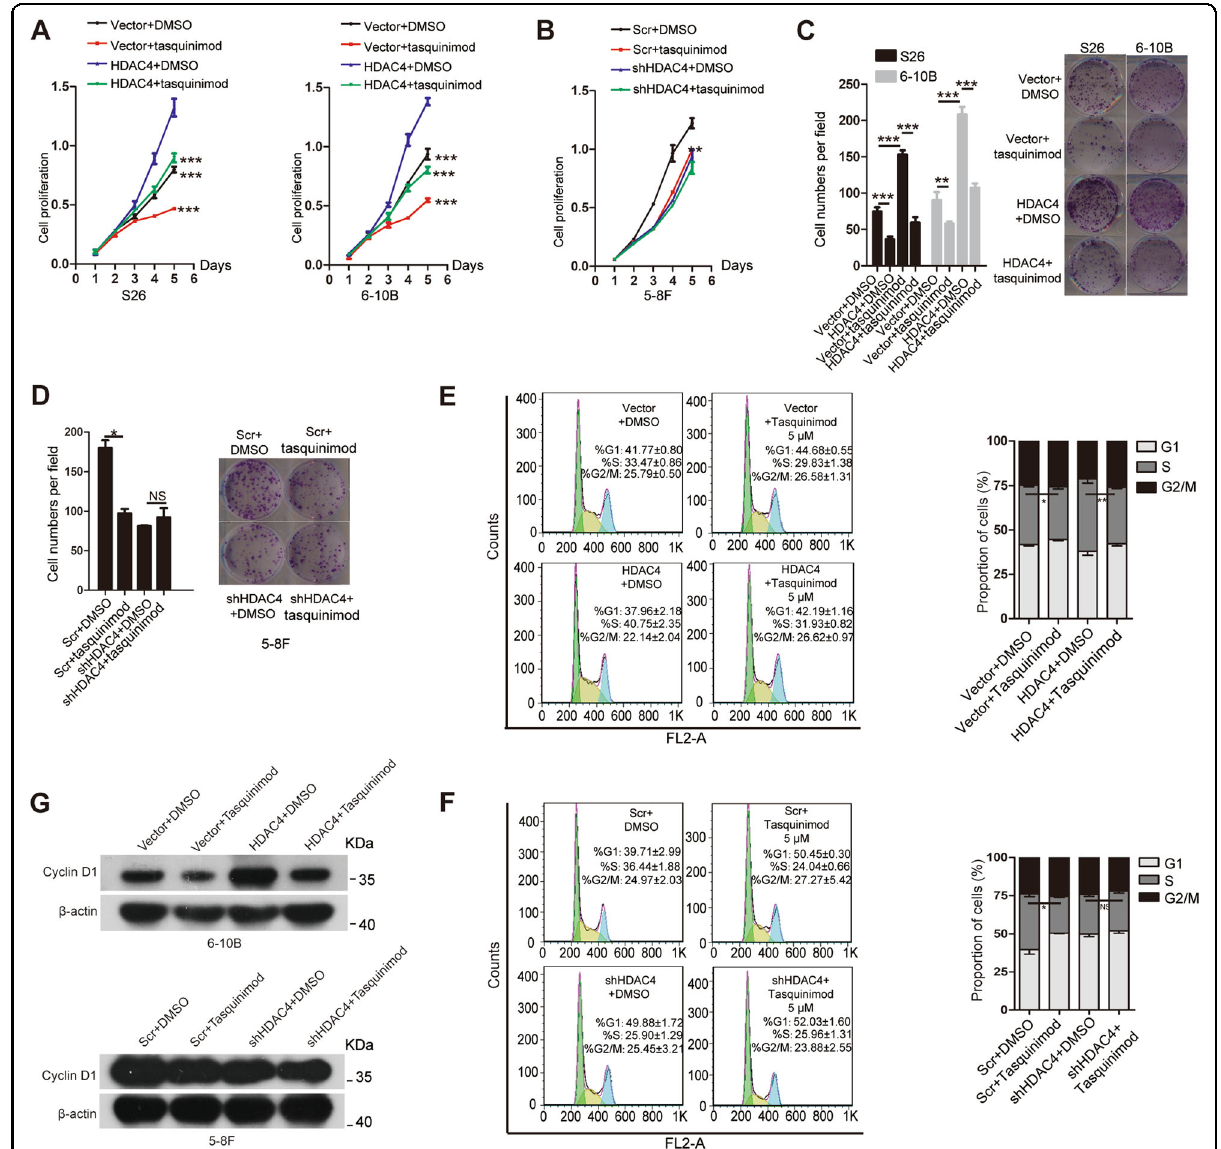
Fig. 5 Tasquinimod suppresses the HDAC4-induced promotion of cell proliferation in vitro. A – D Cell proliferation was analyzed in the indicated stable cell lines by CCK8 ( A , B ) and colony formation assays ( C , D ) after treatment with 5 μ M tasquinimod or vehicle (DMSO) for 48 h. The images on the right ( C , D ) are representative images, and the images on the left ( C , D ) are the statistical results. The data are presented as the means ± SD of three independent experiments. Student ’ s t -test, * P < 0.05, ** P < 0.01, *** P < 0.001. NS: nonsigni fi cant. E , F Cell cycle was investigated in the indicated cells via fl ow cytometry after treatment with 5 μ M tasquinimod or DMSO for 48 h. The left images are representative images. Each colored area represents cells at different phases of the cell cycle: cells in the G1 phase (green area), S phase (yellow area), and G2/M phase (blue area). The right images are the statistical results. The data are represented as the means ± SD of three independent experiments. Student ’ s t -test. * P < 0.05, ** P < 0.01. NS: nonsigni fi cant. G The protein levels of cyclin D1 in the indicated cells were determined by western blotting after treatment with 5 μ M tasquinimod or DMSO for 48 h. β -Actin was used as a loading